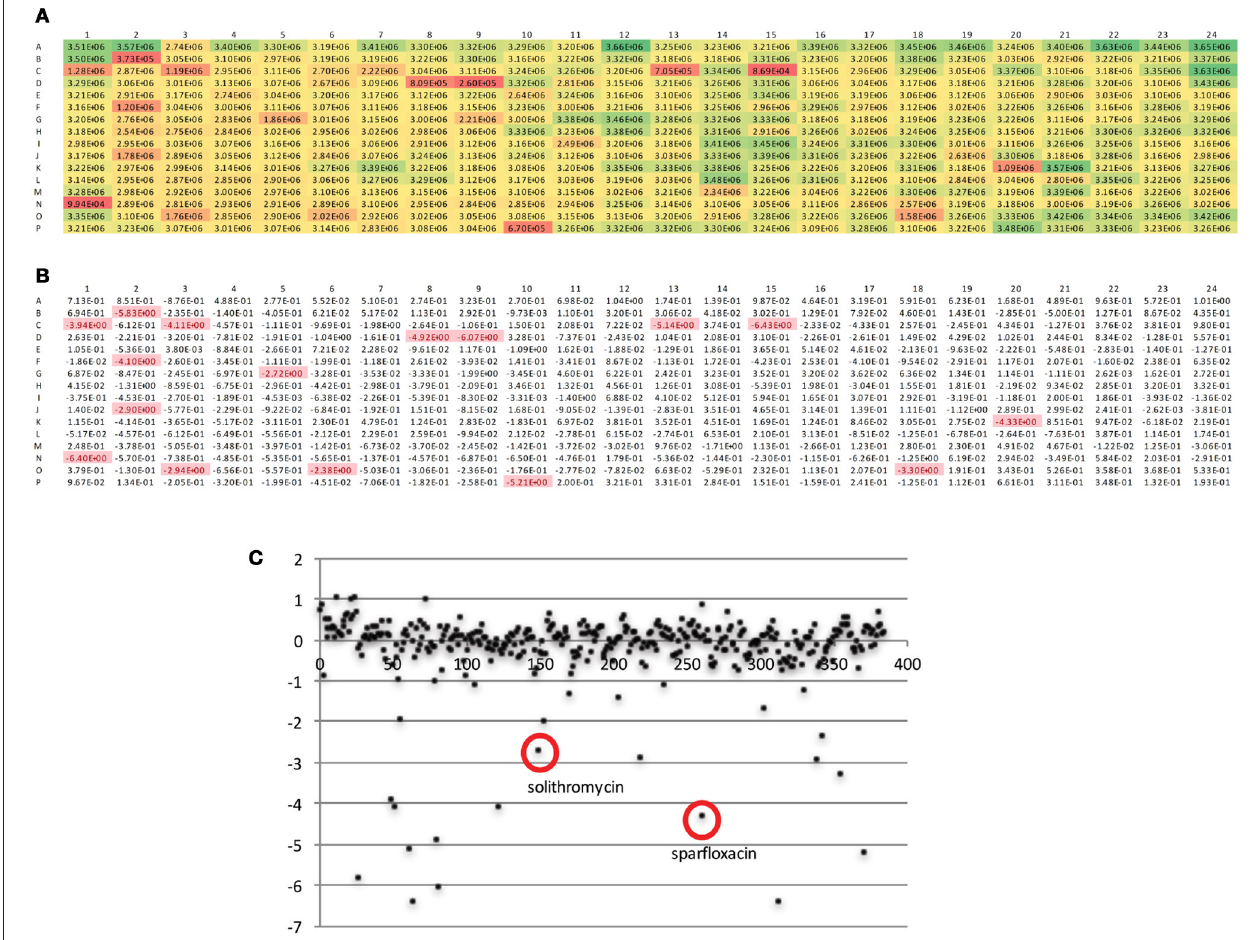
FIGURE 4 | Analysis of fluorescent readout data from a representative 384-well plate. (A) Raw fluorescent data as obtained from plate read. (B) Data from (A) transformed into z-scores, calculated as z = x – m/s where m = median of sample plate, and s = sample standard deviation; a z-score of − 2 or lower was considered to indicate a “hit.” (C) Scatter plot of z scores, x-axis is compound number (1-384), known anti-bacterials within this compound plate are